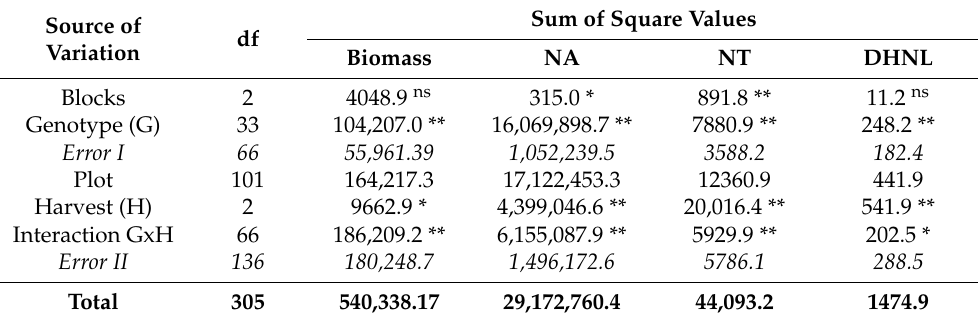
Table 1. Sum of square values for biomass, Nepetalic acid (NA), Nepetalactone (NT) and Dihy- dronepetalactone (DHNL).